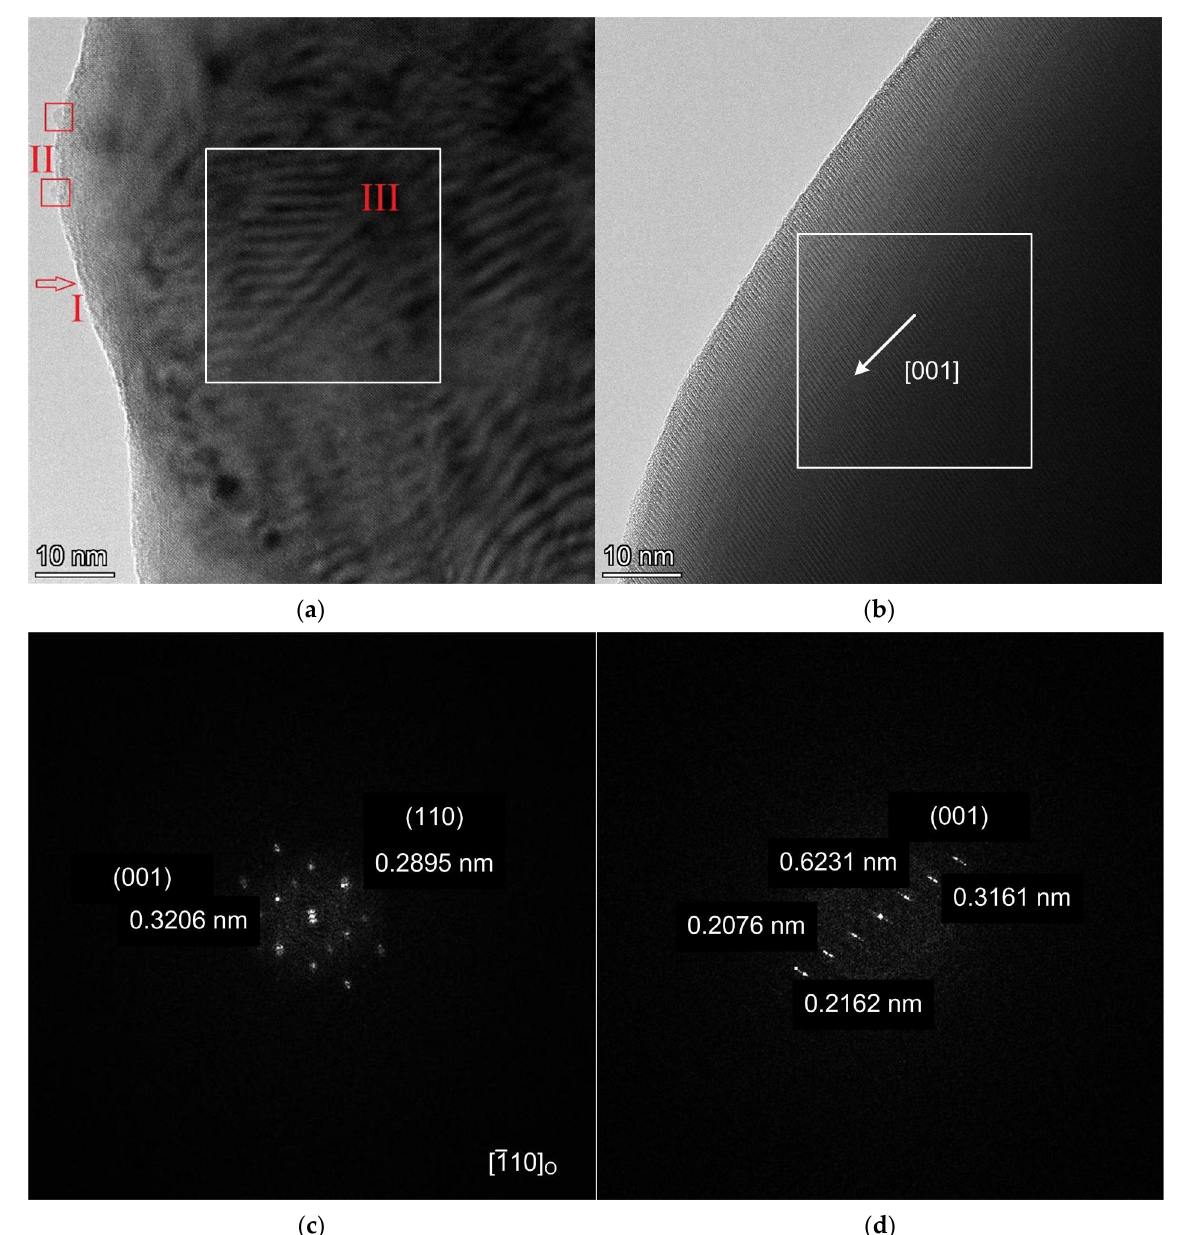
Figure 6. HRTEM images of LCNO_01_t sample (I—amorphization on the surface; II—nano-sized particles on the surface; III—disorientated planar defects)—( a , b ); FFT image of LCNO_01_t sample from ( a ) (area marked by white square, zone axis [ 1(cid:3364)10 ]) showing microstrains—( c ); FFT image of LCNO_01_t sample from ( b ) (area marked by white square, zone axis [110]) showing diffuse scattering—( d ).